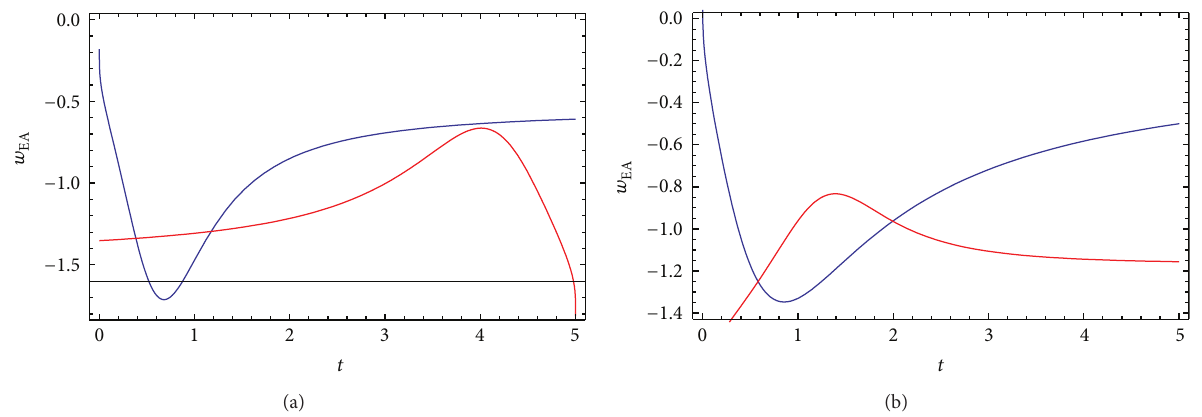
against 𝑡 for ECHDE and ECNADE models. Blue line represents type I model and red line EA